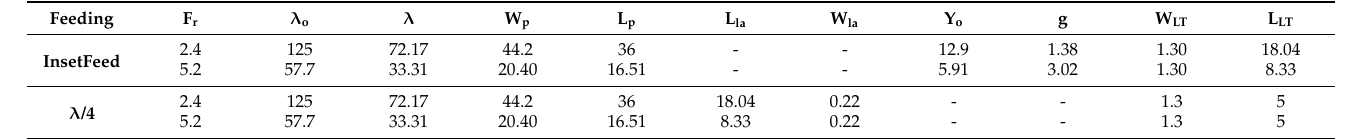
Table 5. Calculation of antenna parameters depending on feed type and